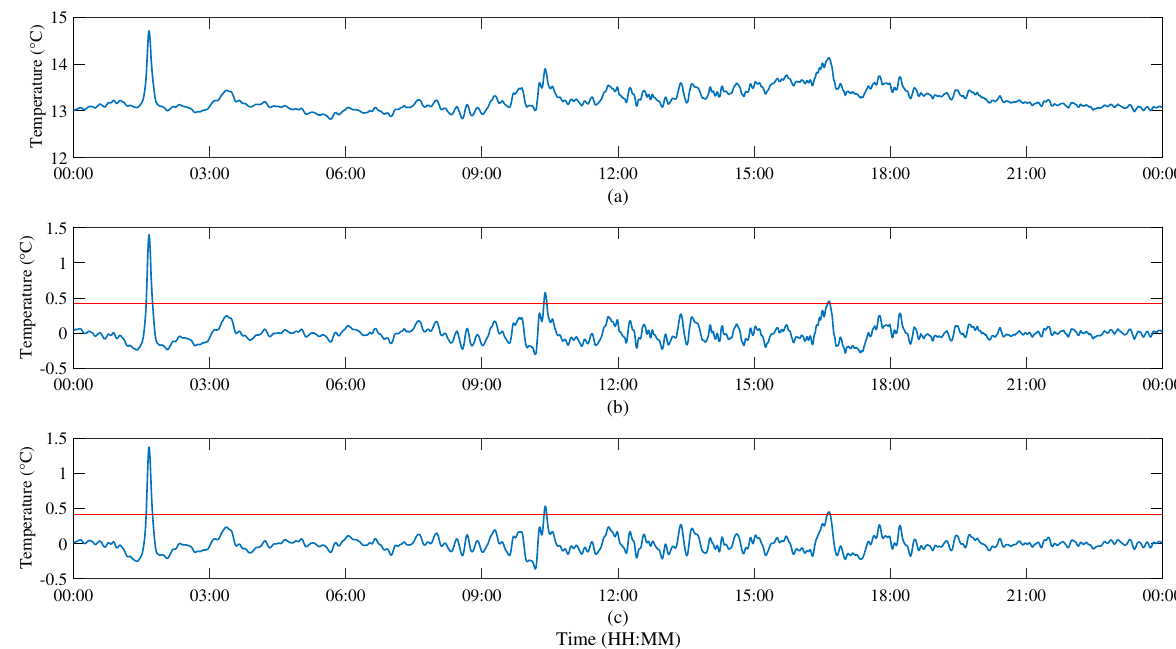
Figure 11. Schematic of identification of ISWs by TS method. ( a ) The depth-averaged temperature in the whole water column. ( b ) Sum of the first five IMFs of EEMD. ( c ) Sum of filtered depth-averaged temperature, the red lines are the index lines with a value of